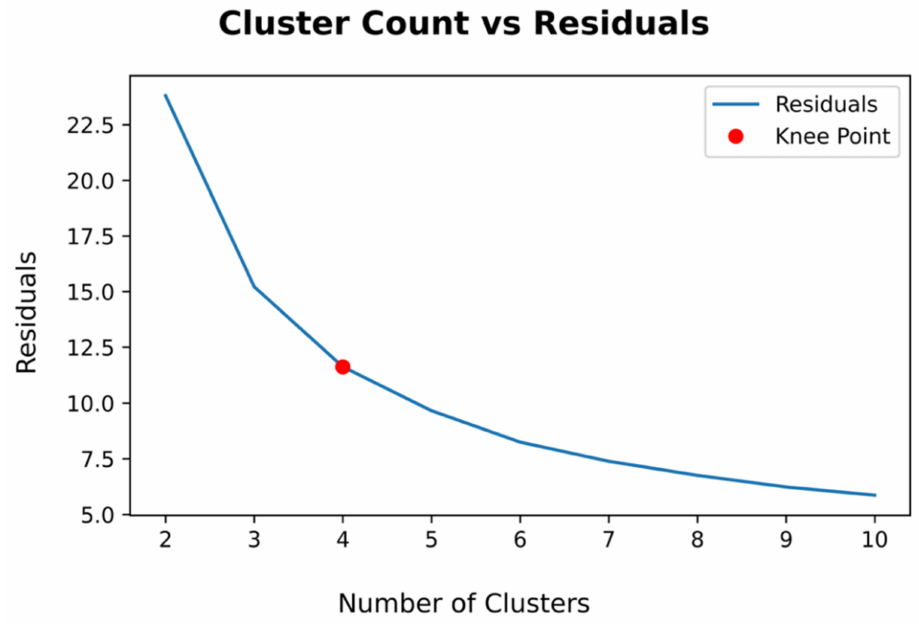
Figure 4. Plot of k-means cluster residuals (error) vs. the number of clusters with the knee point